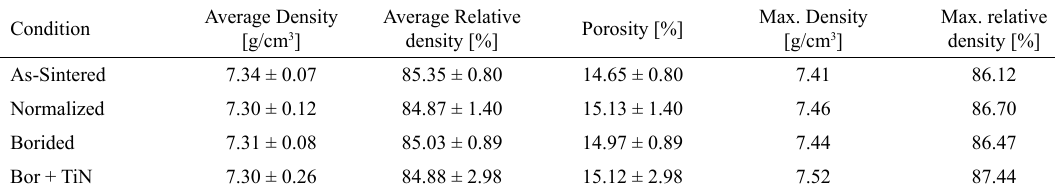
Table 3. Geometric and relative density of each condition